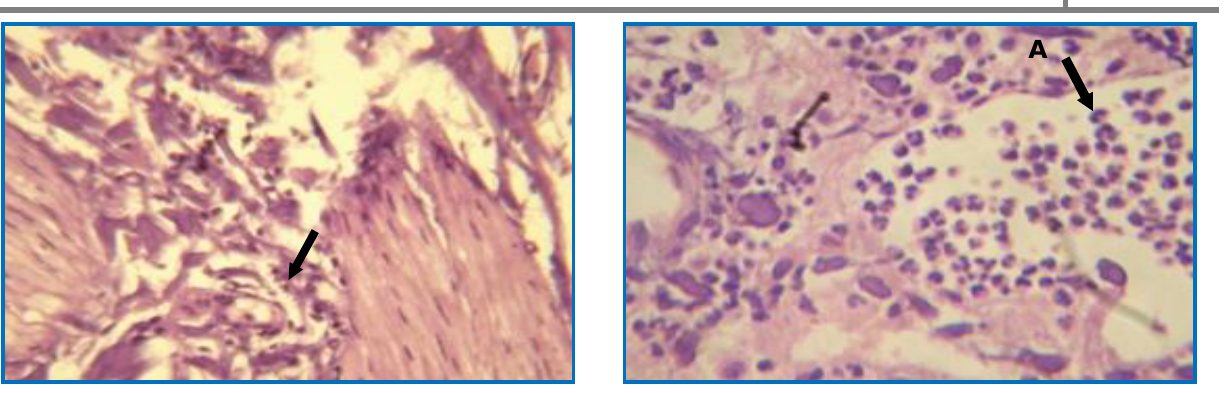
Figure, 3: There are neutrophils infiltration Figure, 4: Show neutrophils aggregation in dilated between muscle fibers. Group A, three days post blood vessel (A). Group B, three days post A operation, (H and E 40X). operation (H and E40X)